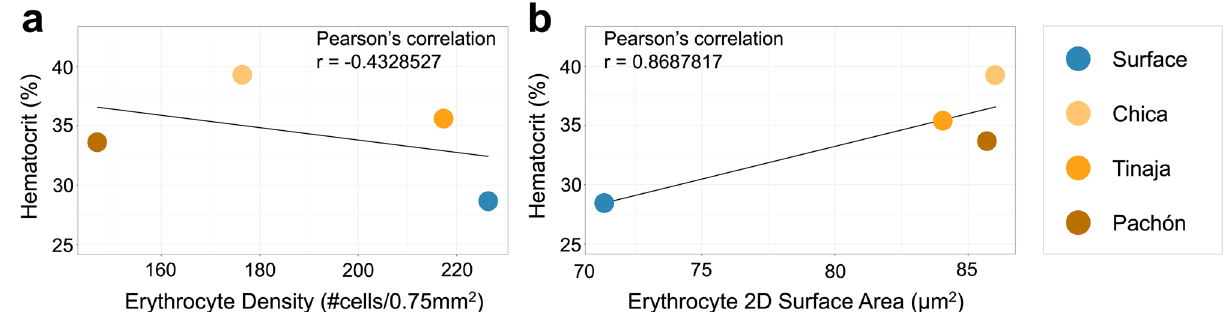
Figure 5. Erythrocyte size is positively correlated with hematocrit values in Astyanax cave and surface fish. We performed Pearson’s correlations to determine which erythrocytic feature (density or size) is correlated with hematocrit. Mean erythrocyte density was not correlated with hematocrit (r = − 0.4329, a ). However, population erythrocyte two-dimensional surface area provided a strong, positive correlation with hematocrit value (r = 0.8688, b ).